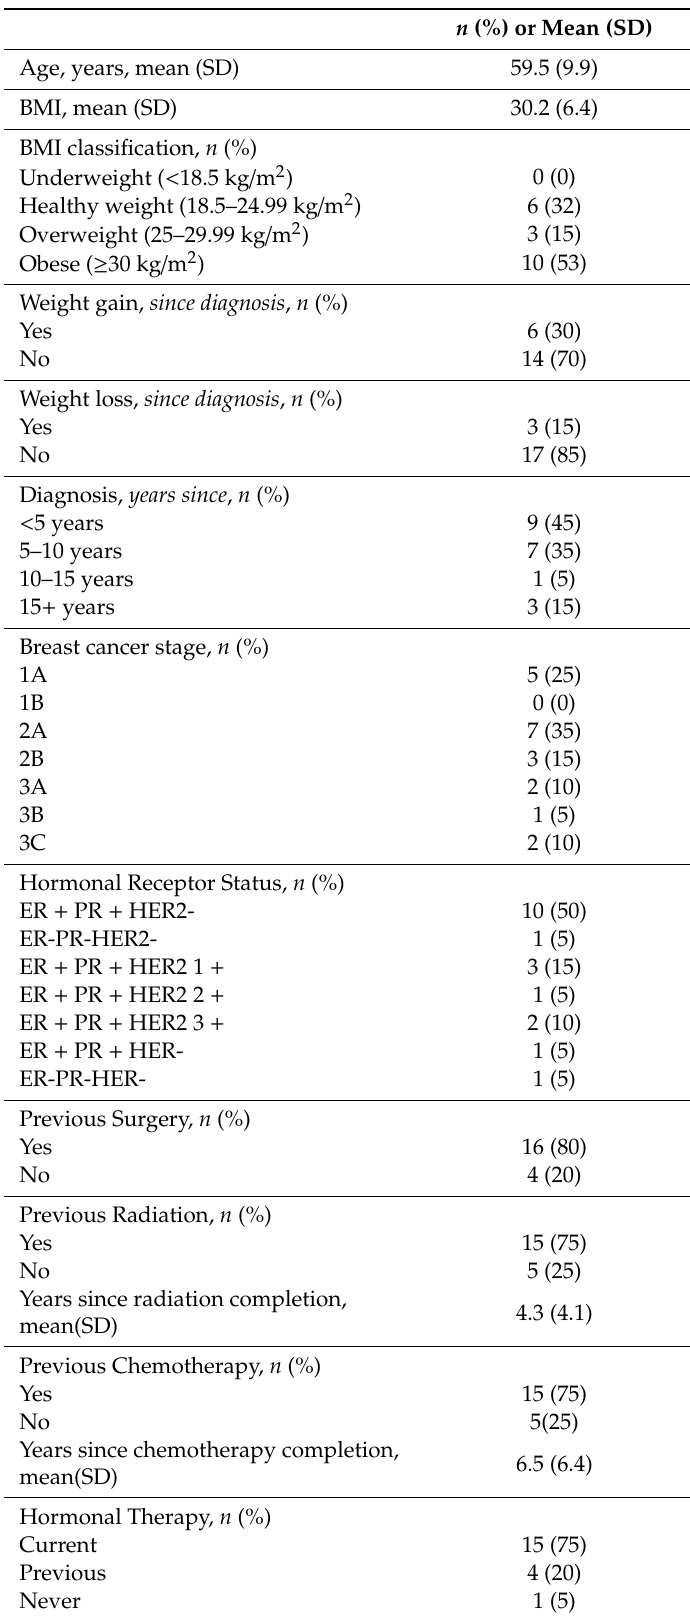
Table 1. Characteristics of the participants ( n = 20) recruited into the NutriCare pilot